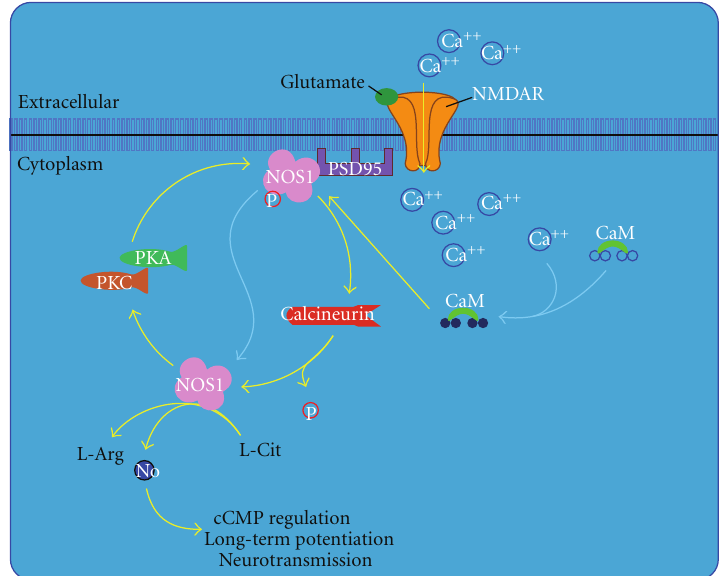
Figure 6: Nitric oxide signaling pathway extracted from BioCarta database [9].